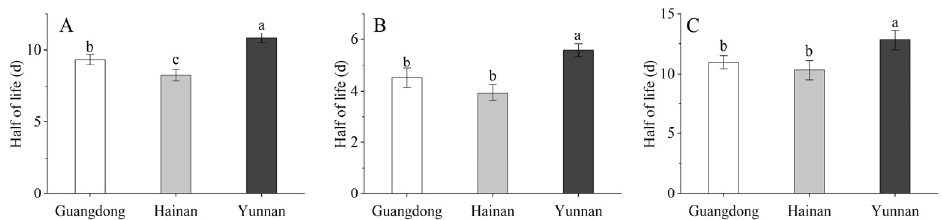
Figure 4. Half-life of prochloraz in a whole banana ( A ), banana peel ( B ), and banana pulp ( C ). Note: data are presented as mean ± SE ( n = 3), with different lowercase letters in the same chart indicating significant differences at p < 0.05 using Duncan’s range test.